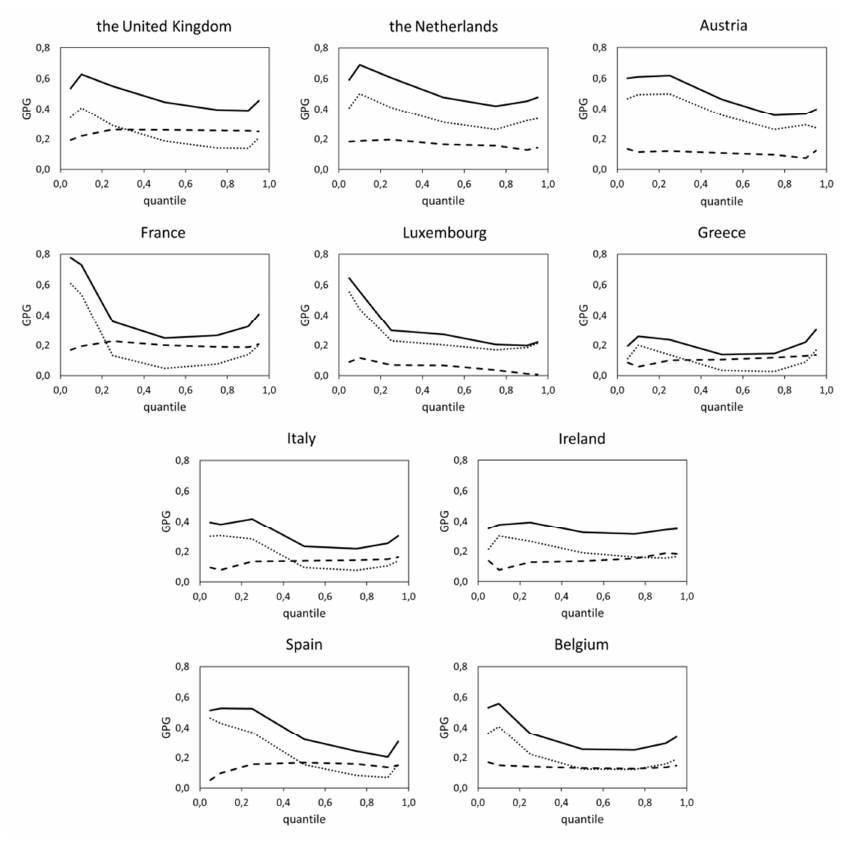
Figure 4. The differences between the log income distributions for men and women vs. quantile rank in the group